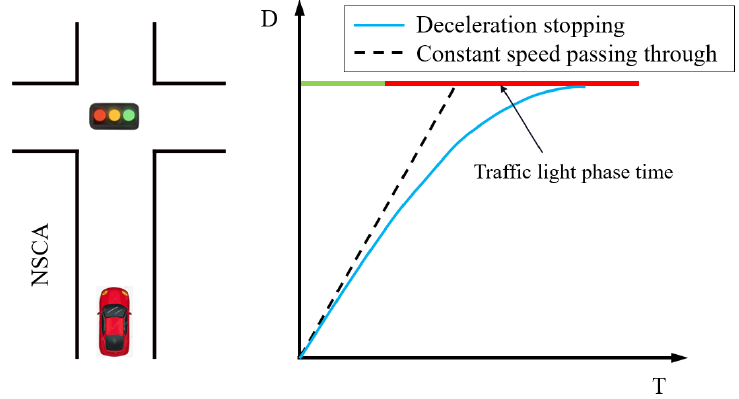
Figure 10. Green-light phase deceleration stopping.